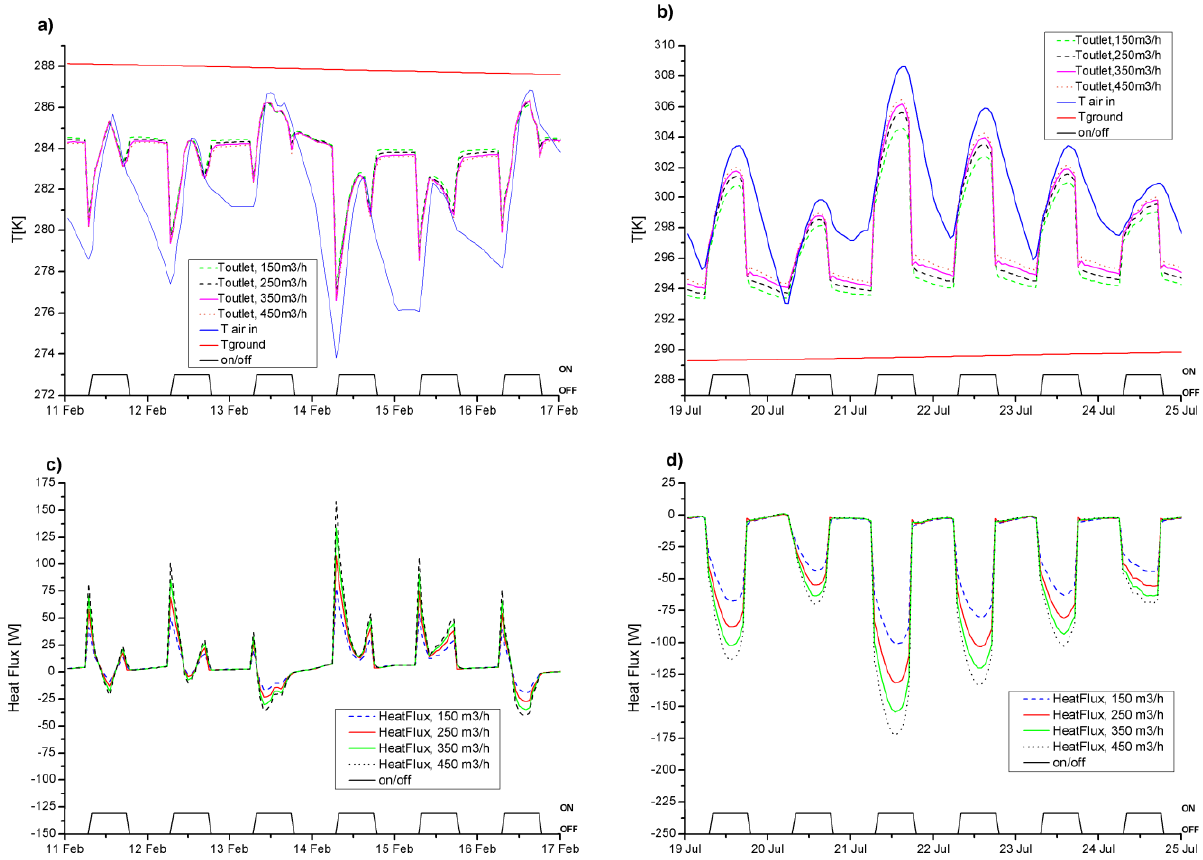
Figure 12. Ground and inlet-outlet air temperatures with λ = 1 W/m K, air-ground thermal power varying the air flow rate (range 150–450 m 3 per hour), for typical winter ( a , c ) and summer weeks ( b , d ).